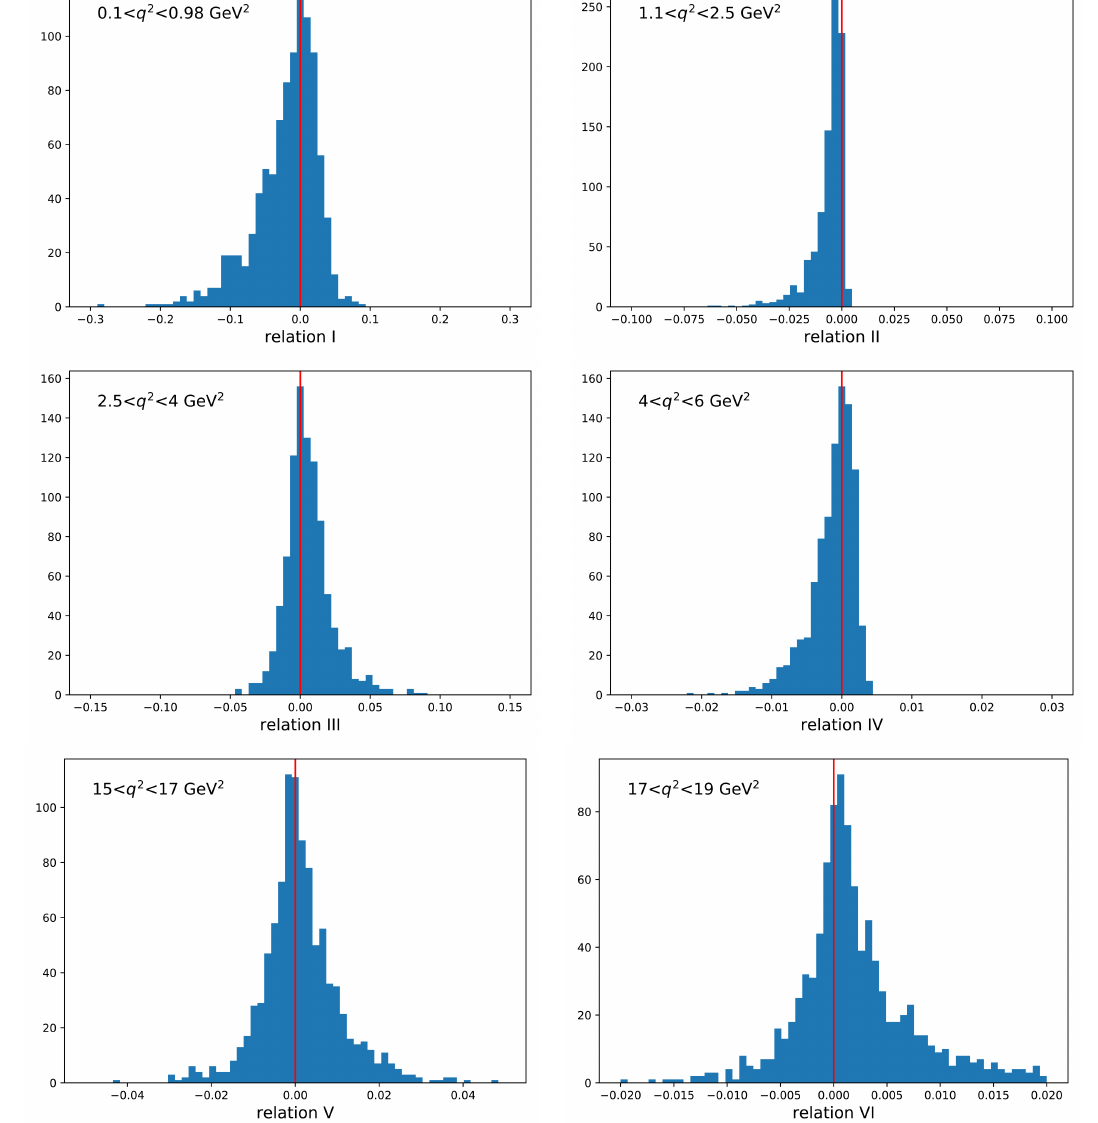
Figure 19 . Example distributions of the six symmetry relations for the various q 2 bins. The red line is a reference at 0 for the case when the relations are exact. The spread of the distributions is a reflection of the statistical precision of the